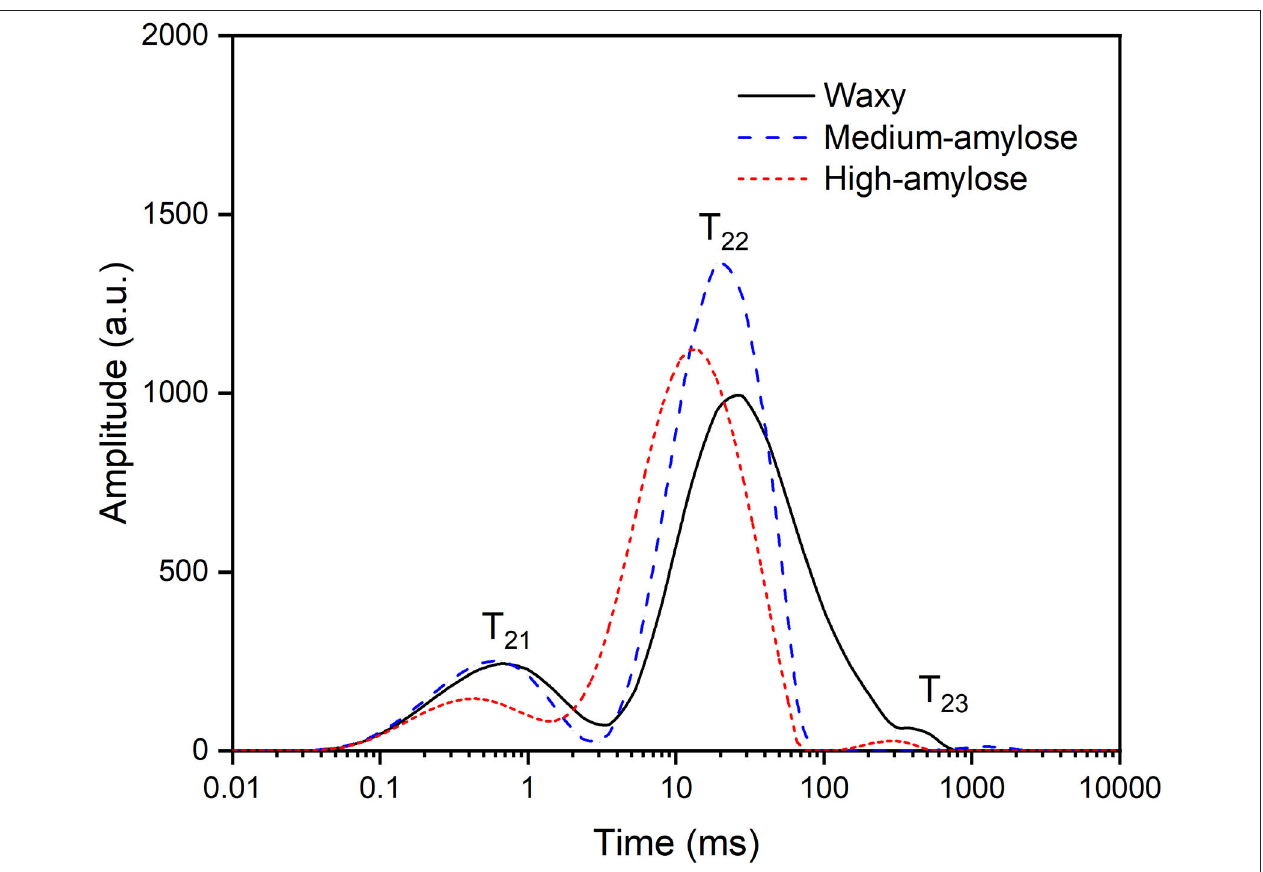
FIGURE 4 | Proton distributions of cooked parboiled black